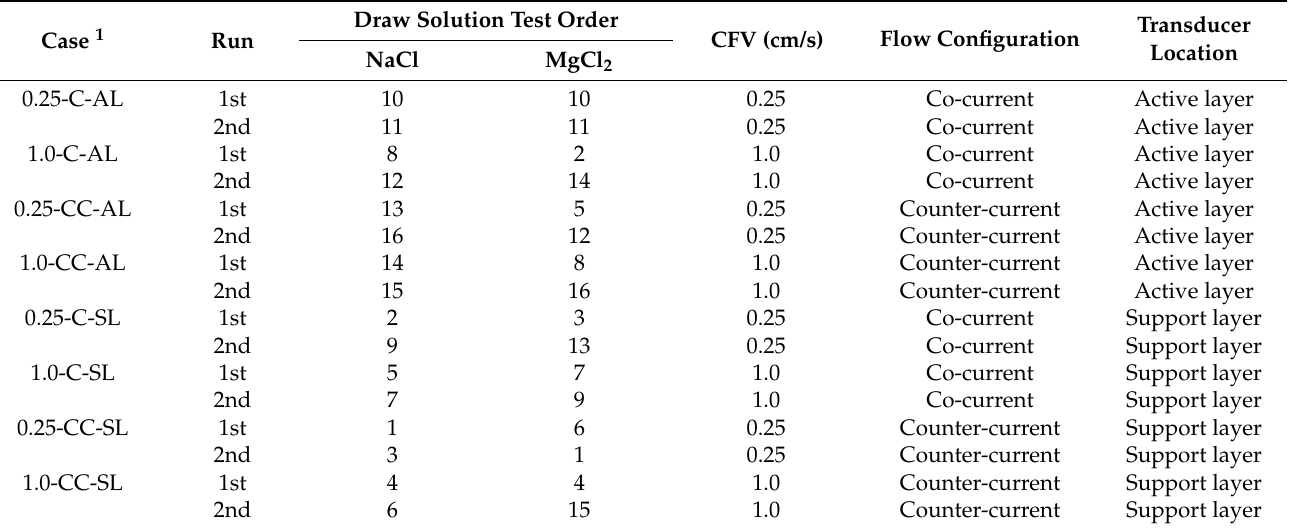
Table 2. Testing arrangement for NaCl and MgCl 2 draw solutions with the use of